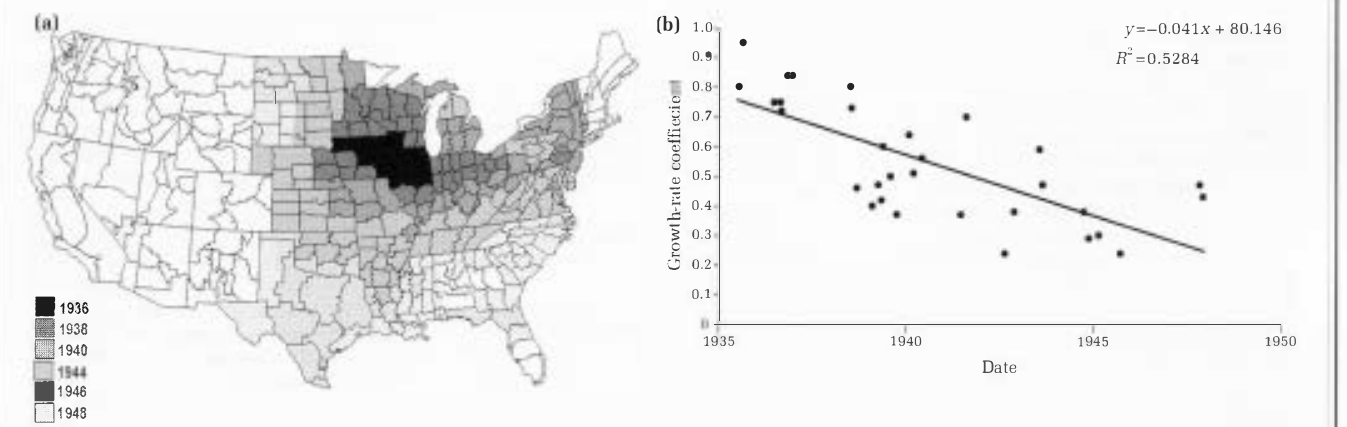
Figure 2 (a) Diffusion of hybrid corn usage, showing areas that planted ten or more per cent of their corn acreage to hybrid seed at successive time intervals (redrawn after Griliches 1960 ]. (b) Within-state rate of increase of hybrid corn use, plotted against the date of arrival in each state(the date at which hybrid corn reached 10% of all corn). Data from Griliches (1 957) with revised growth coefficient estimates from Dixon (1980; coefficient b2). From Steele (forthcoming; seen.